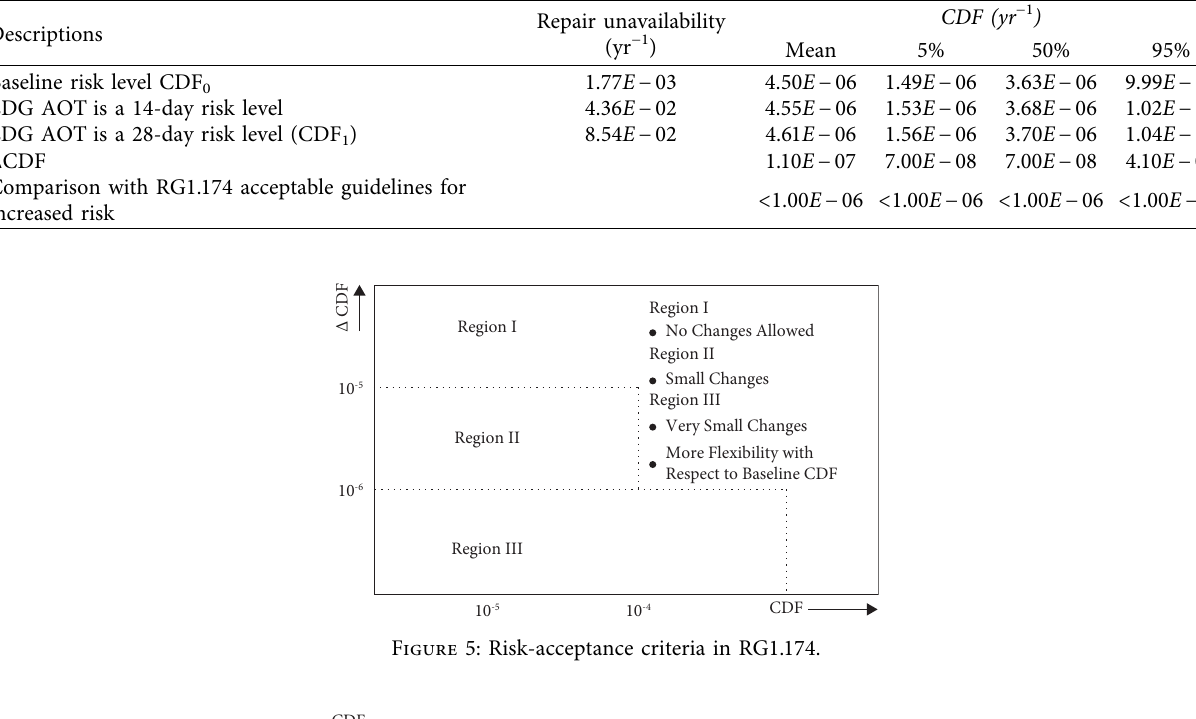
Table 1: EDG AOT extended to 28 days CDF.